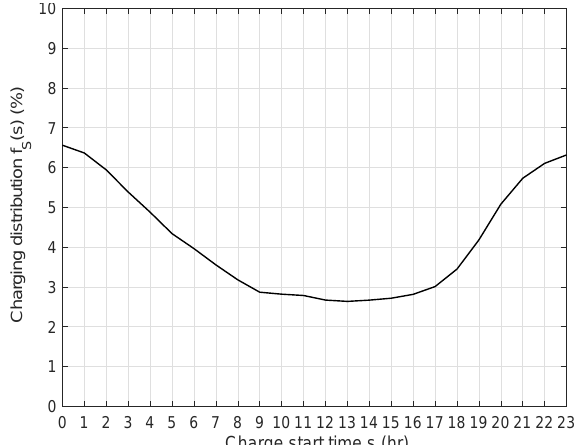
Figure 5. Example of the charging start time distribution f S : slow charger usage over the time interval (KPX, June 2021).